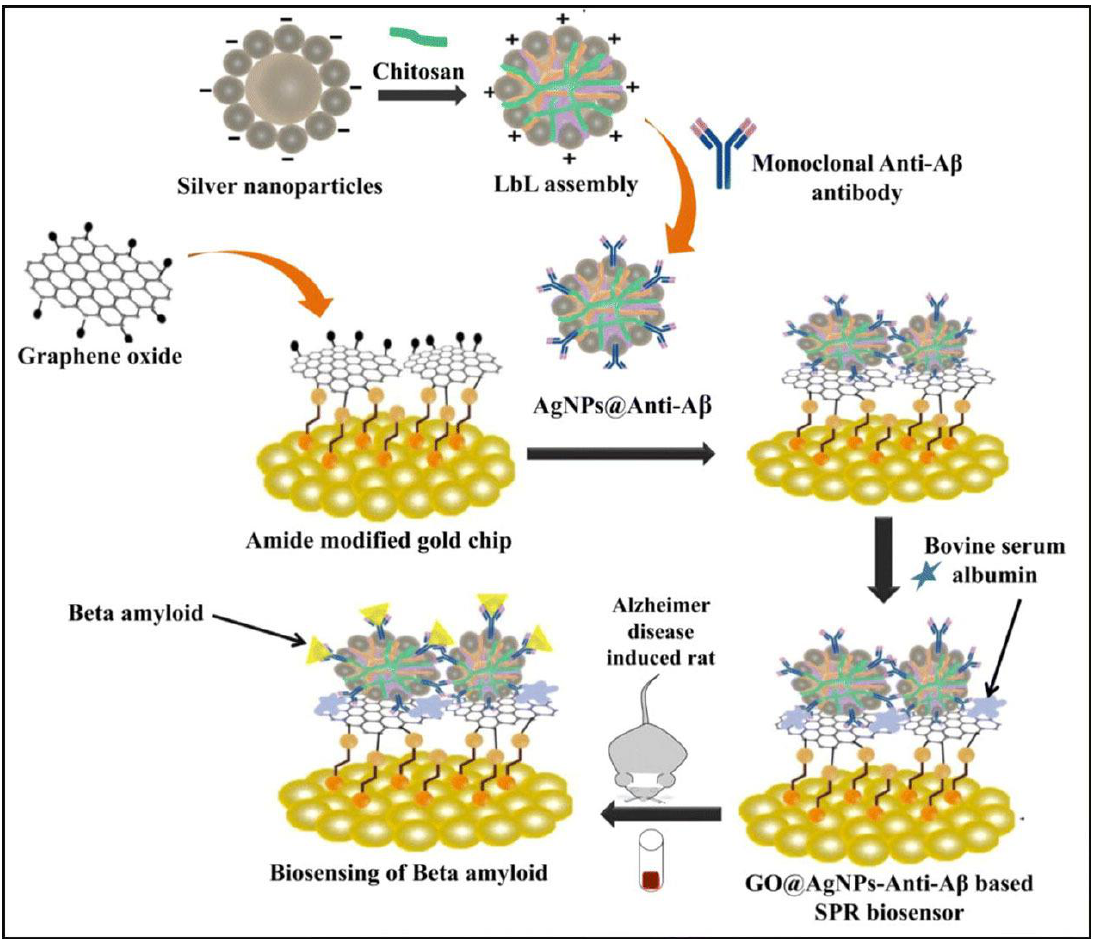
Figure 8. Fabrication of the Ab- β -amyloid/AgNPs-Cs-polystyrene sulfonate (PSS)/GO biosensor for detection of the β -amyloid biomarker. The gold chip was first functionalized with an amine group followed by immobilization of GO sheets via EDC/NHS reaction. LbL assembly was formed by three main components: AgNPs, chitosan (Cs, positively charged polymer) and polystyrene sulfonate (PSS, negatively charged polymer). Reproduced from [94] with permission of